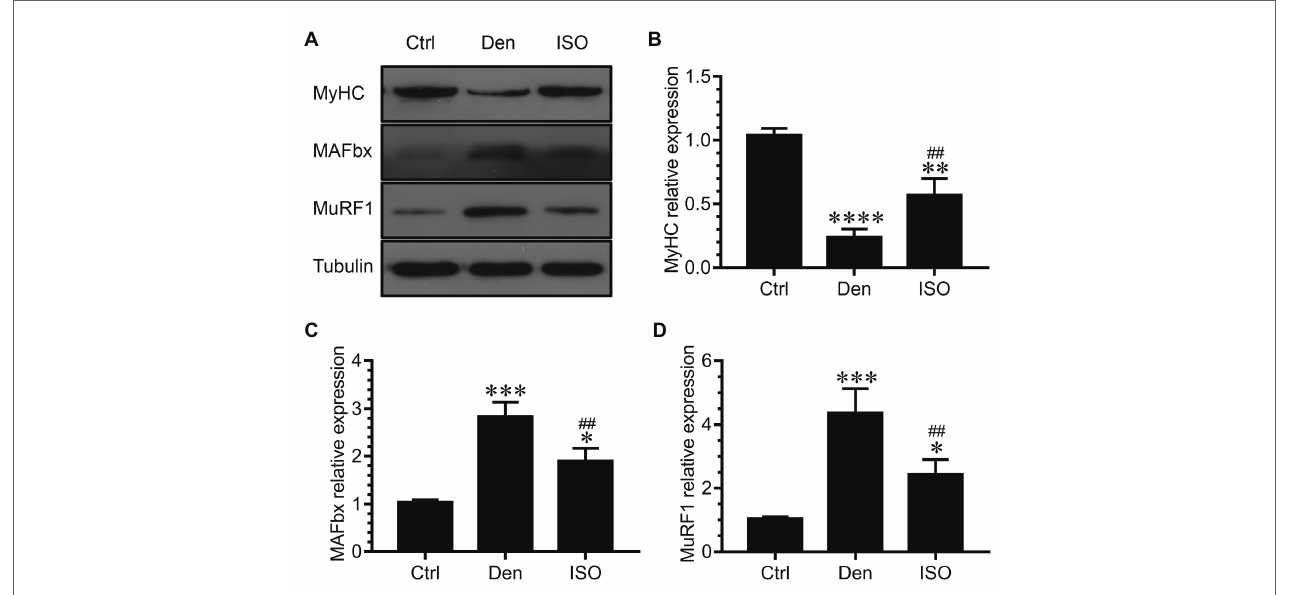
FIGURE 2 | Isoquercitrin inhibits proteolysis via the ubiquitin-proteasome pathway ( n = 6). (A) Western blot of MyHC, MAFbx, and MuRF1. (B–D) Quantification of the expression of MyHC, MAFbx, and MuRF1. Ctrl, control group; Den, denervation group; ISO, denervated target muscle plus middle-dose isoquercitrin (20 mg/kg/d) group. * p < 0.05, ** p < 0.01, *** p < 0.001, and **** p < 0.0001 vs. Ctrl; ## p < 0.01vs. Den. MyHC, myosin heavy chain; MuRF1, muscle RING finger 1; MAFbx, muscle atrophy